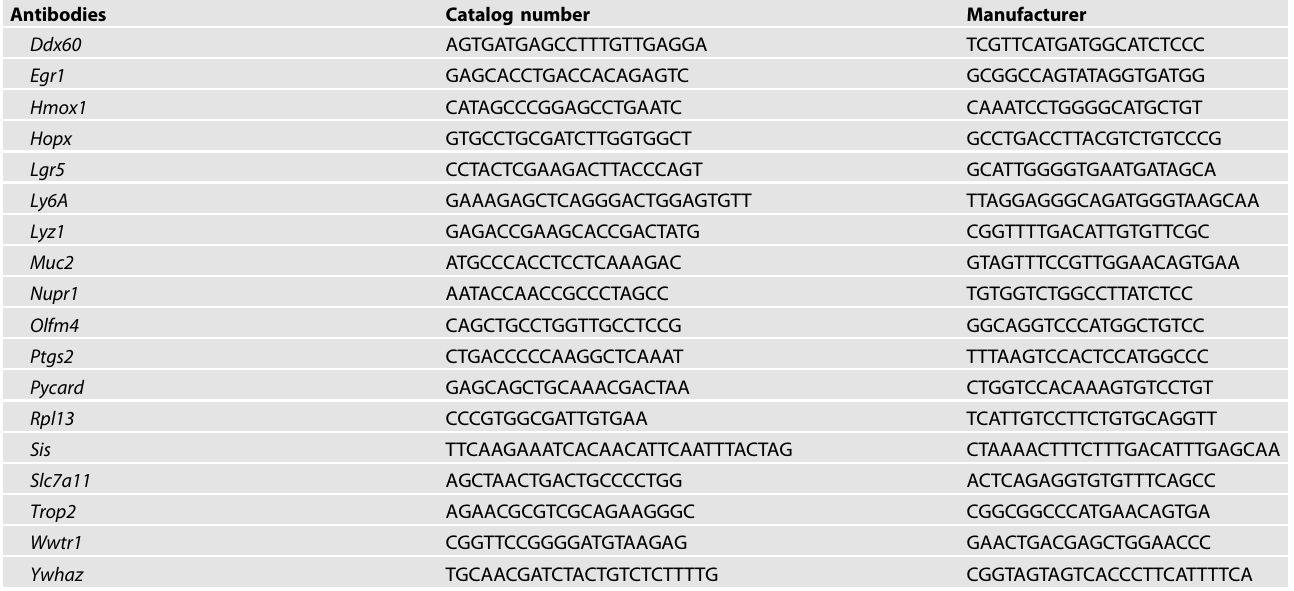
528 nm using the Microwin software on Mithras LB940 reader (Berthold Technologies). Statistical analysis Statistical analyses were performed with Graph Pad Prism 5. All experimental data are expressed as mean ± s.e.m. unless indicated in Figure legends. The signi fi cance of differences between groups was determined by appropriate parametric or non-parametric tests as described in the text or Figure legends.